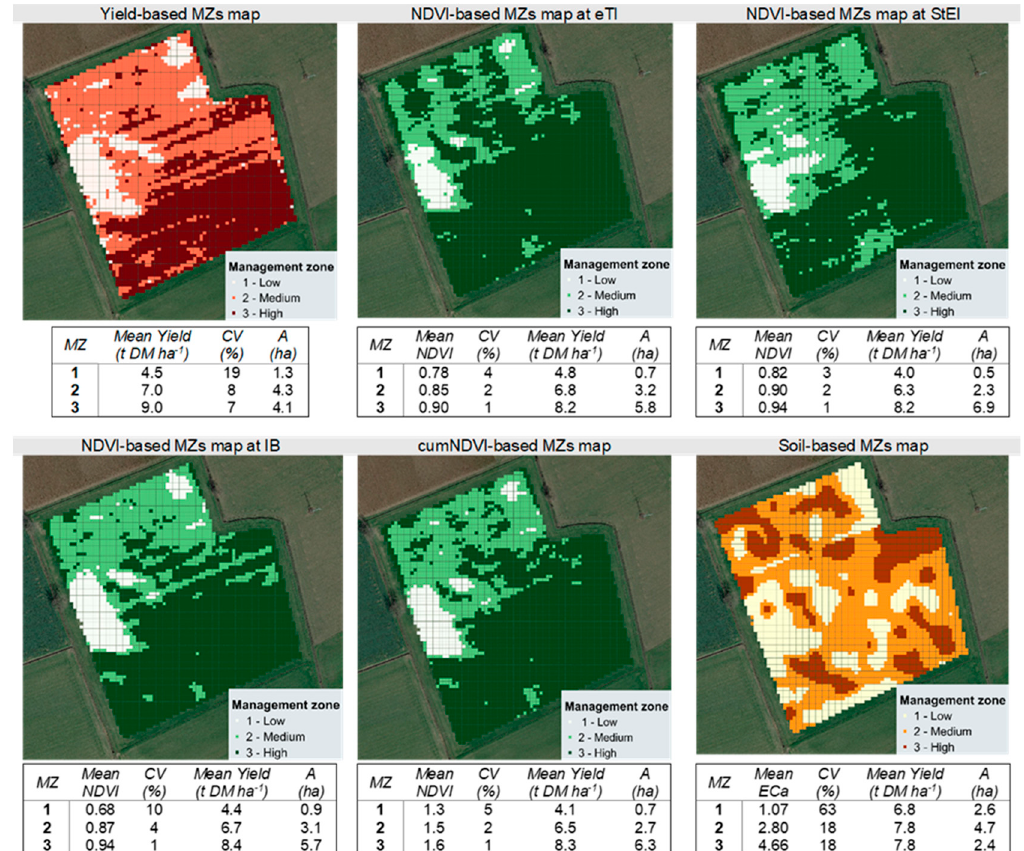
Figure 4. Management zone (MZ) maps resulting from yield data; NDVI measured at early tillering stage (eTl), stem elongation stage (StEl), late booting stage (lB); cumulative NDVI (cumNDVI); ECa. For each map and MZ, the mean value and the coefficient of variation (CV) of the predictor is reported, as well as the average yield and the covered area.